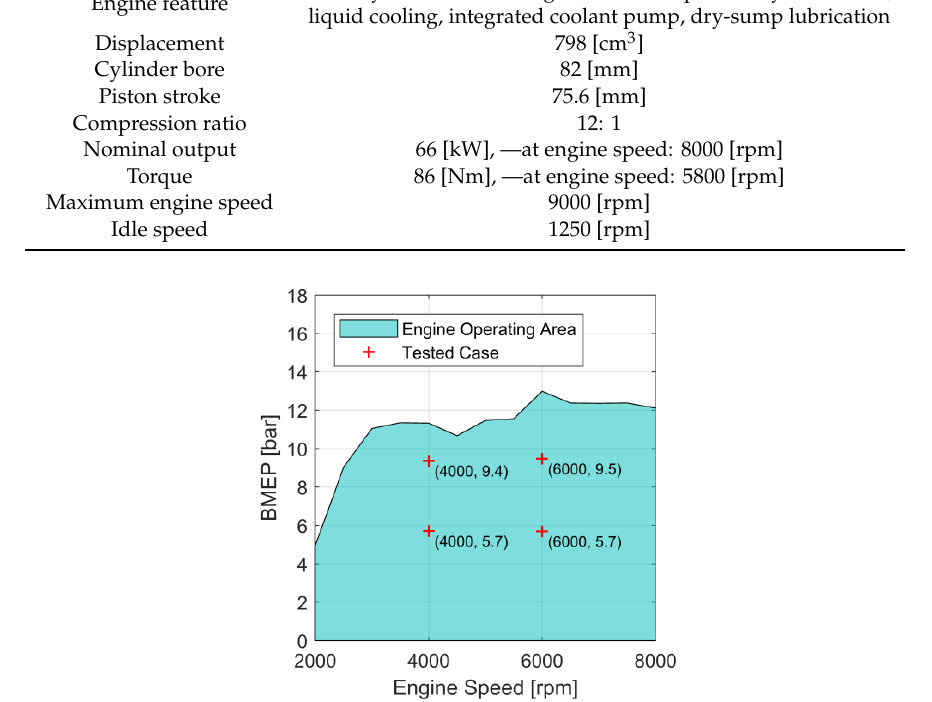
Figure 5. Tested cases for model validation.